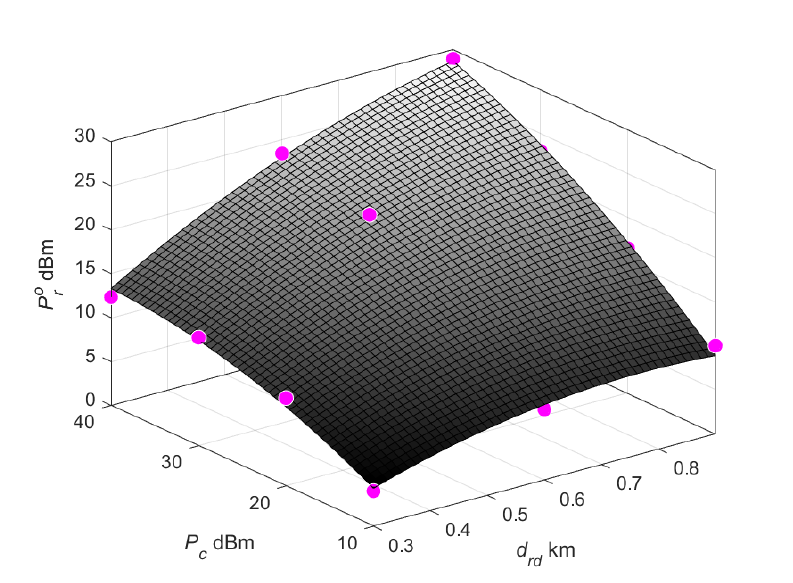
Figure 7. Surface fitted from P o r with a buffer in Figure 6 by using a polynomial surface fitting